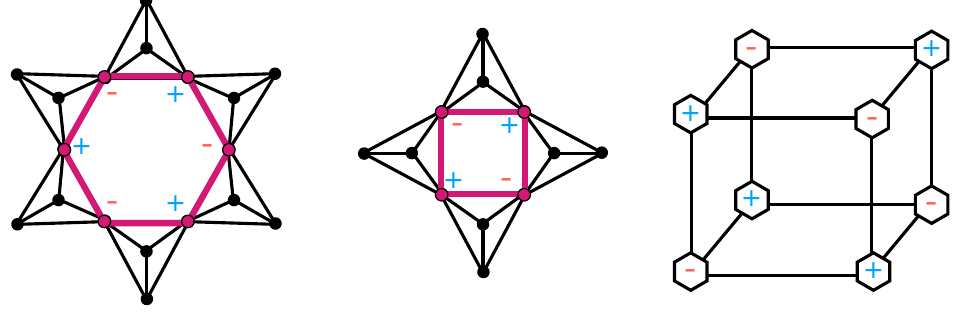
Figure 5: The possible magnon localization domains (LDs) of the SOD60 molecule on the hexagons and squares (see Sec. 6.1). The ± sign indicates the amplitude in Eq.